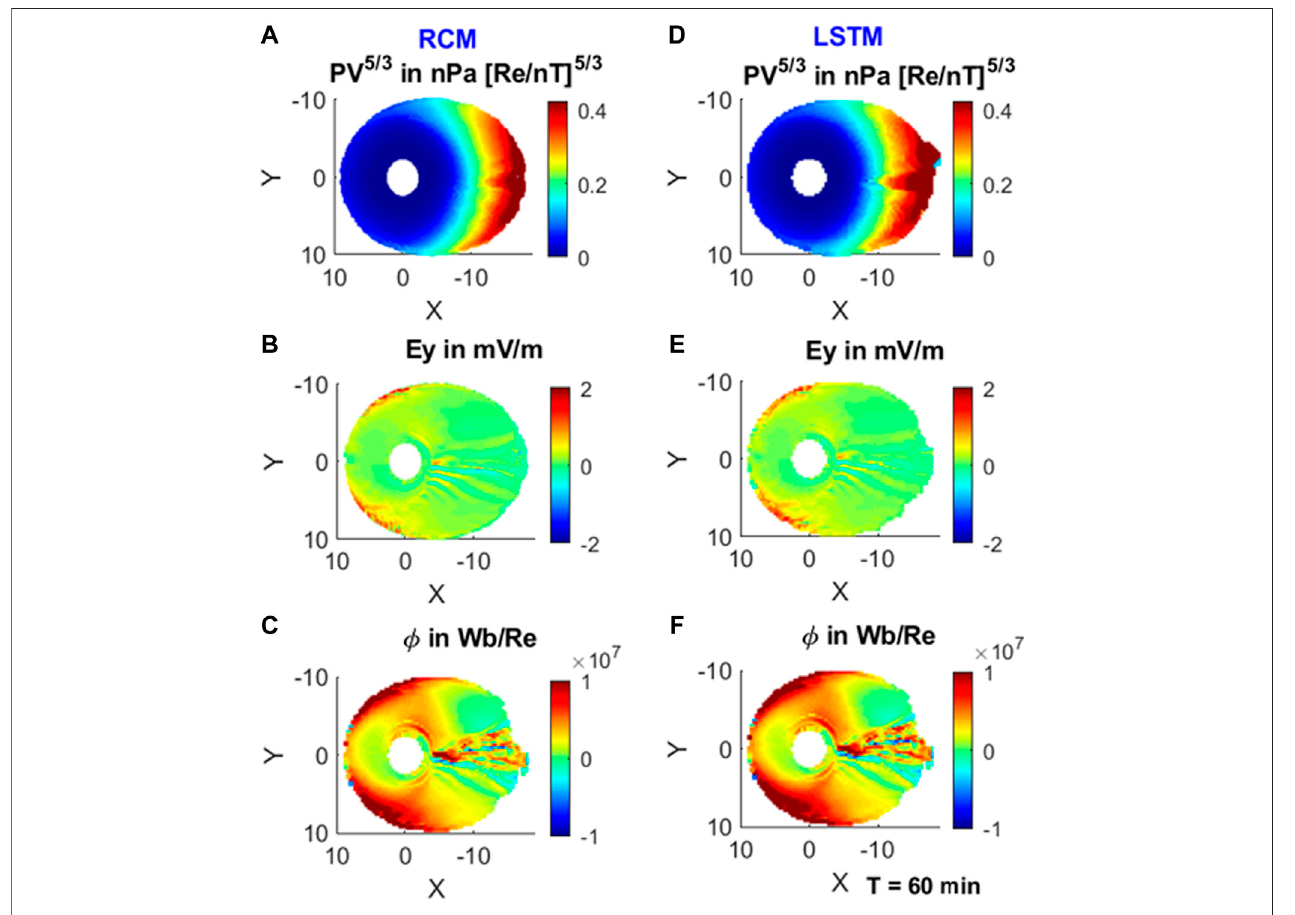
FIGURE 8 | Similar to Figure 5 , but for T (cid:1) 60